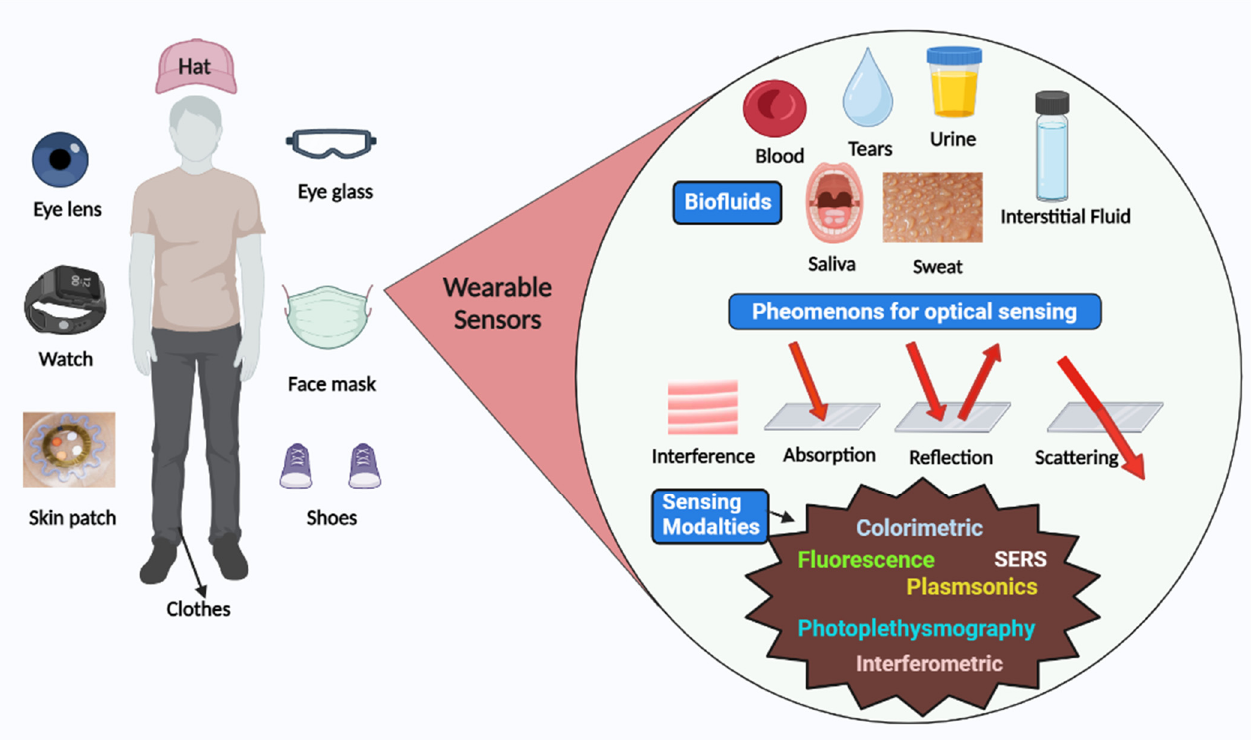
Figure 2. Schematic representation of various available wearable optical sensors, sensing mechanism, and biofluids for detection.